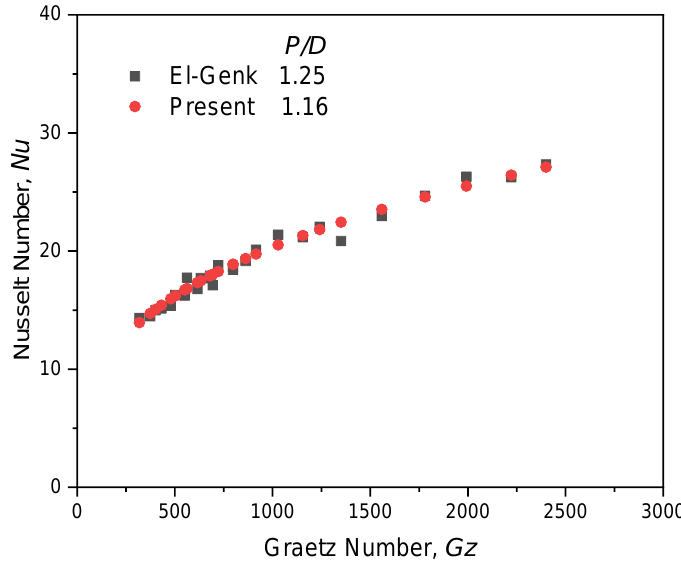
Figure 16. The value comparison of convection in sub-channel vertical square (El-Genk for P/D = 1.25).